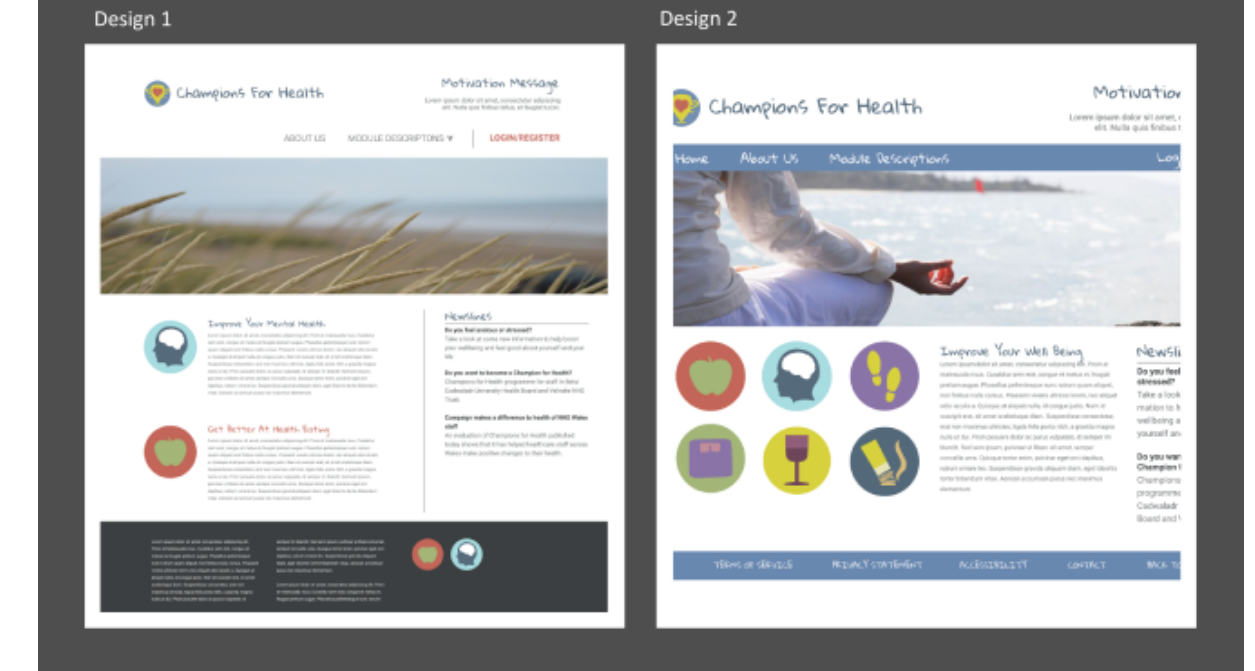
Figure 2. Home page designs version 1 and 2 used in stage